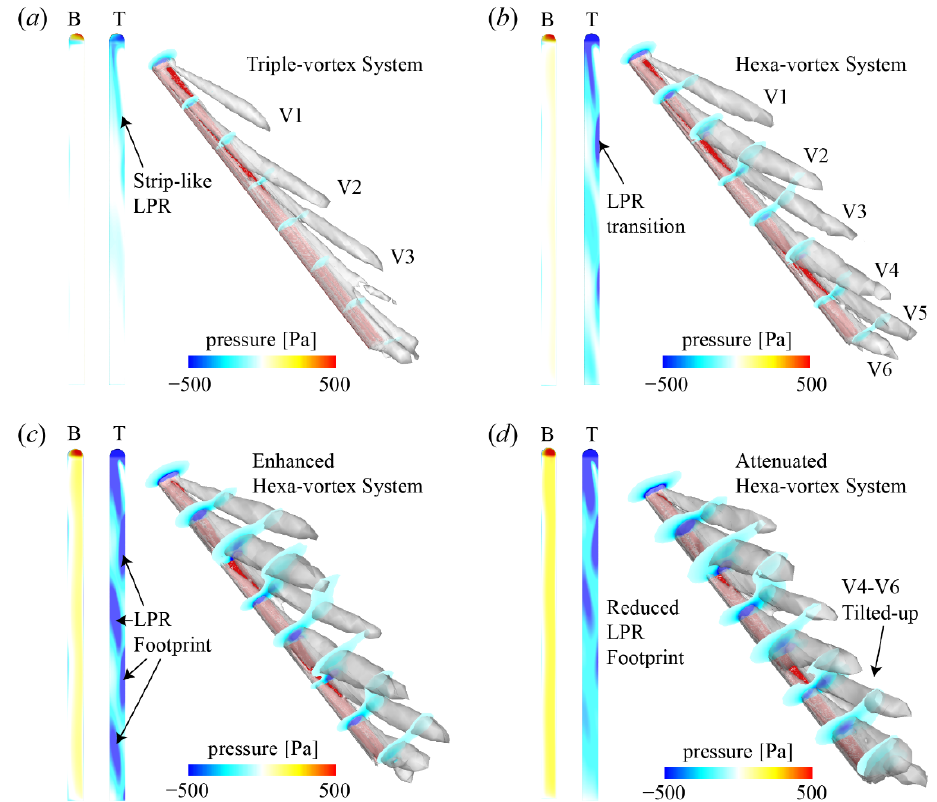
Figure 6. Flow structure and pressure distribution of the ski at β = 20° and γ = 0°: ( a ) α = 10°, ( b ) α = 20°, ( c ) α = 30°, and ( d ) α = 40°. B: bottom view; T: top view; V: vortex. The ski is labeled by the red ( b ) α = 20 ◦ , ( c ) α = 30 ◦ , and ( d ) α = 40 ◦ . B: bottom view; T: top view; V: vortex. The ski is labeled by region. the red